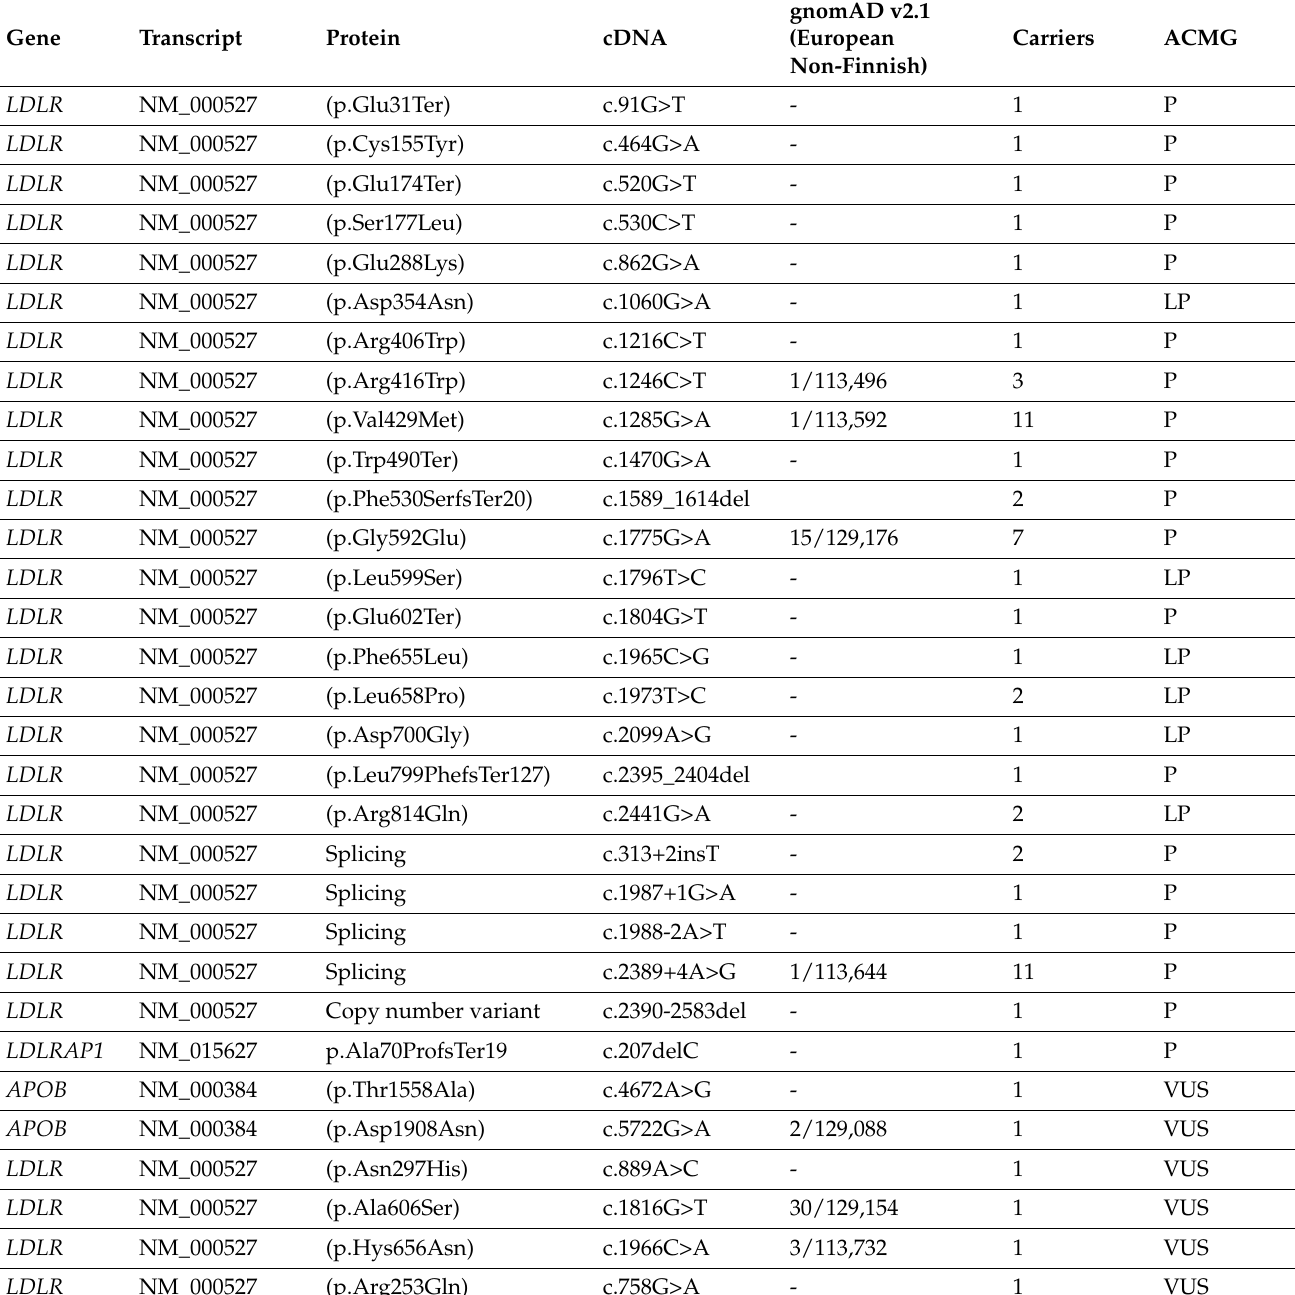
Table 1. Genetic variants identified via NGS which may play a role in